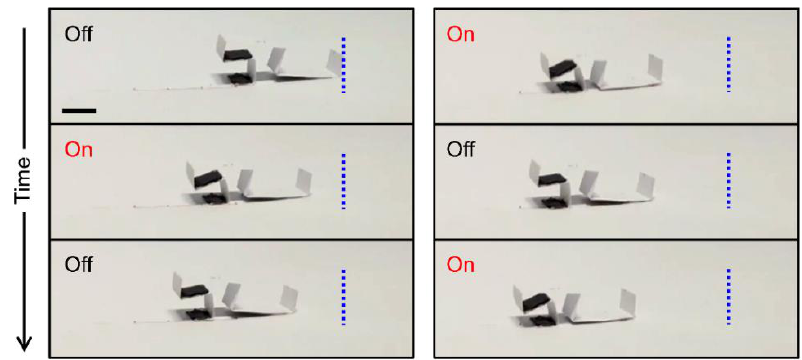
Figure 9. Snapshots of walking soft robot motion. A photograph of the robot’s walking motion experiment taken in chronological order. (Blue line: start line, scale bar: 5 mm).